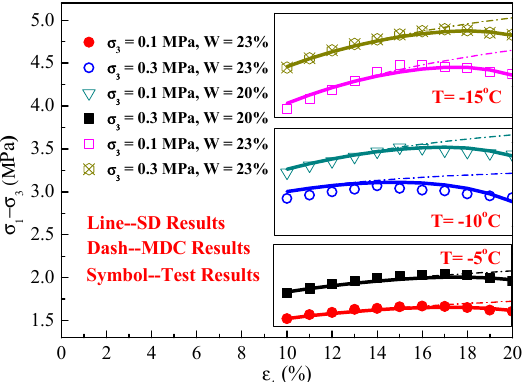
Figure 9. Comparison of experimental and predicted stress – strain curve results.